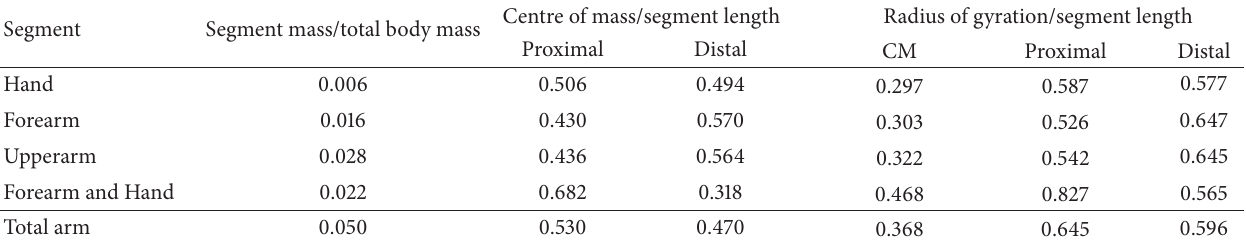
Table 3: Segment mass and lengths of human arm